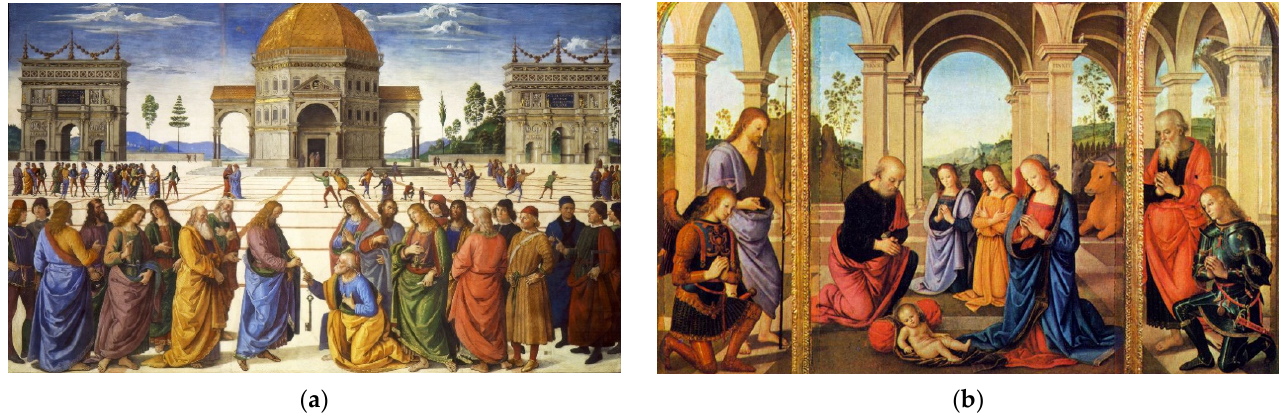
Figure 2. Pietro Vannucci, known as Perugino, ( a ) The Delivery of the Keys, 1481–82, Sistine Chapel, Vatican City, Rome; ( b ) The Nativity (det.), 1491, Albani-Torlonia polyptych, Villa Albani, Rome.